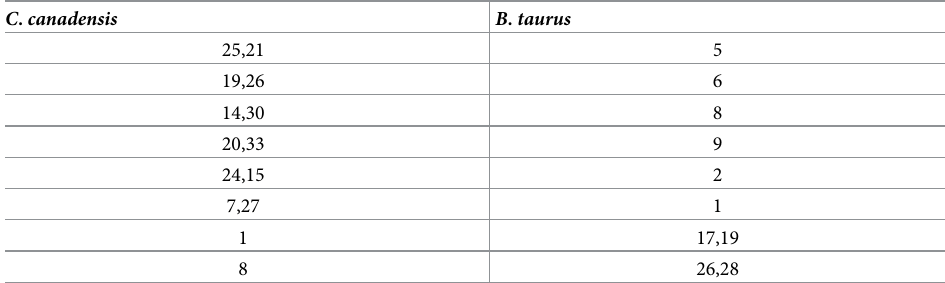
Table 2. Chromosomal fissions and fusions between elk and cattle genomes.